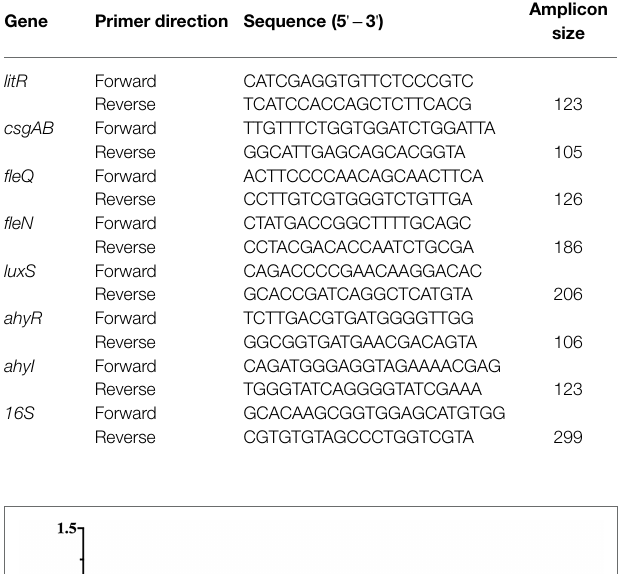
FIGURE 2 | Effect of esculetin at sub-MICs (25, 50, and 100 μ g/ml) on hemolysin production of A. hydrophila SHAe 115. Data are presented as the